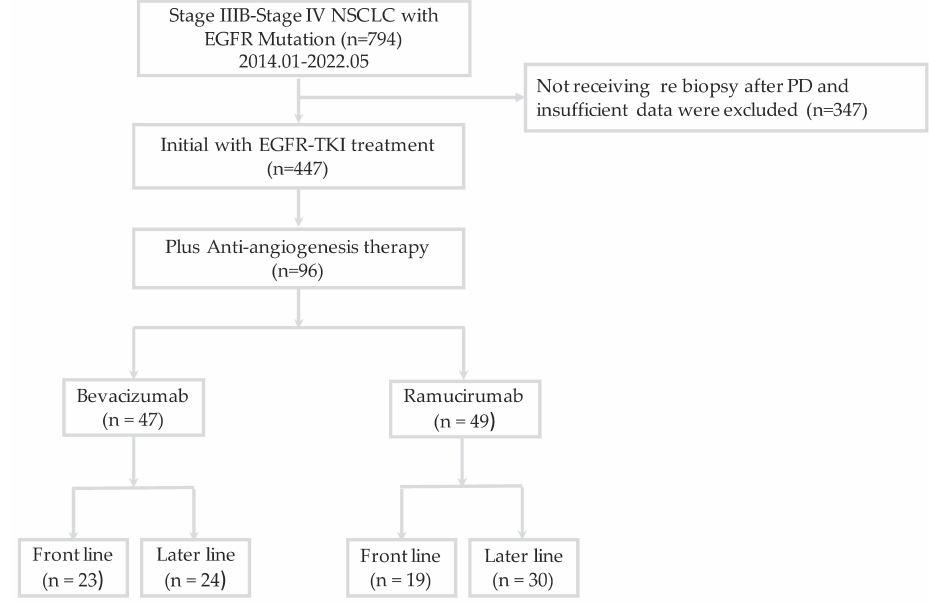
Figure 1. Flowchart of patient enrollment. EGFR, epidermal growth factor receptor; TKI, tyrosine kinase inhibitor; NSCLC, non-small-cell lung cancer; PD, progressive